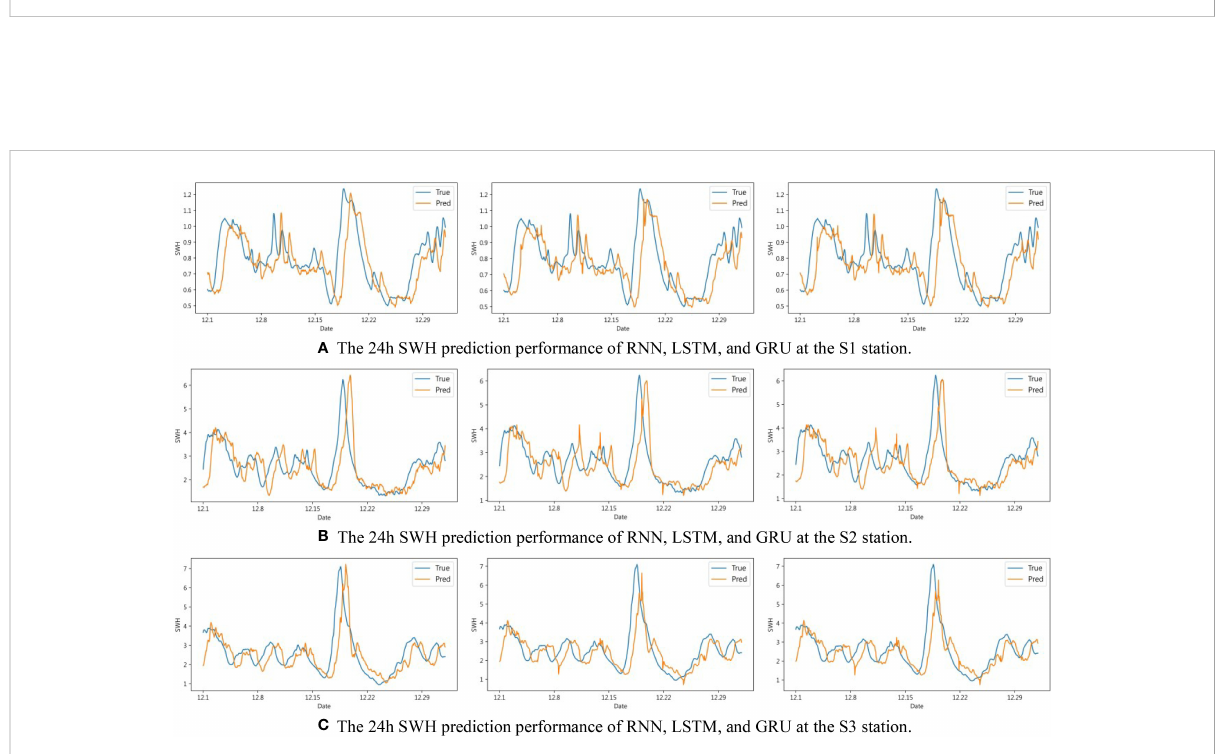
FIGURE 9 24h SWH prediction performance of RNN, LSTM, and GRU at S1, S2, and S3. (A) The 24h SWH prediction performance of RNN, LSTM, and GRU at the S1 station. (B) The 24h SWH prediction performance of RNN, LSTM, and GRU at the S2 station. (C) The 24h SWH prediction performance of RNN, LSTM, and GRU at the S3